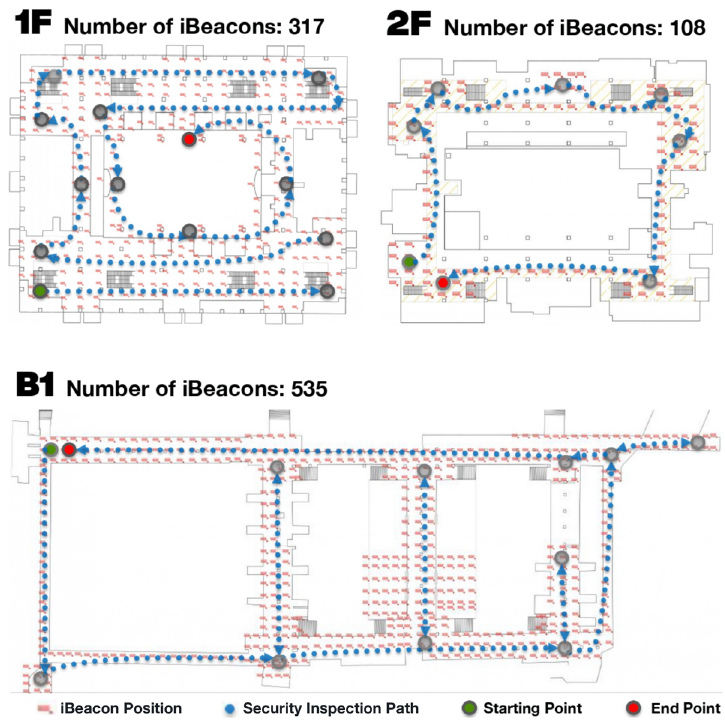
Figure 1. iBeacon locations and regular query route planning at Taipei Main Station.